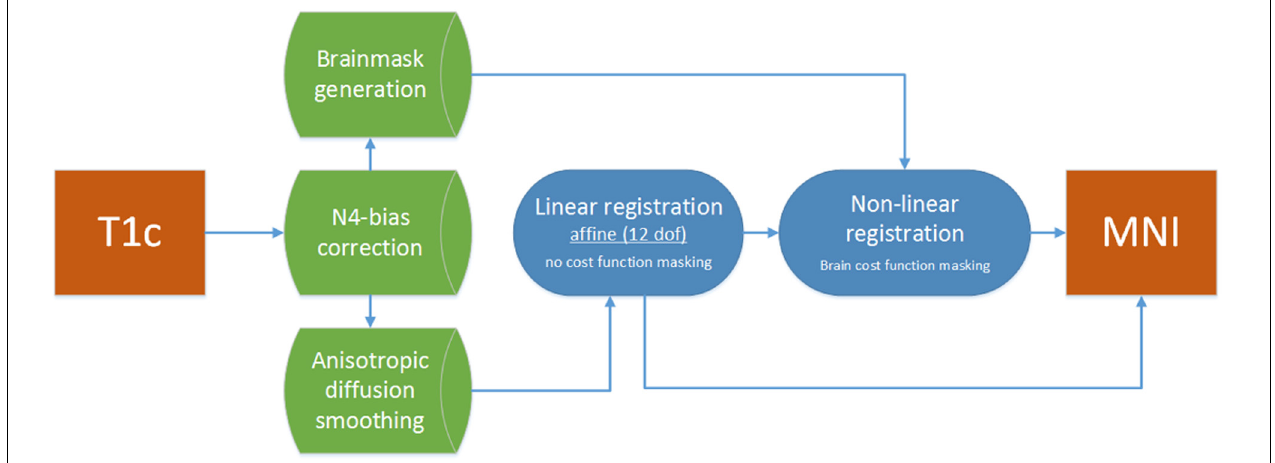
FIGURE 3 | Registration flowchart. Images were bias corrected and smoothed and subsequently passed to the linear registration. Brain masks were used to drive the non-linear registration step, which was initiated with the results of the linear